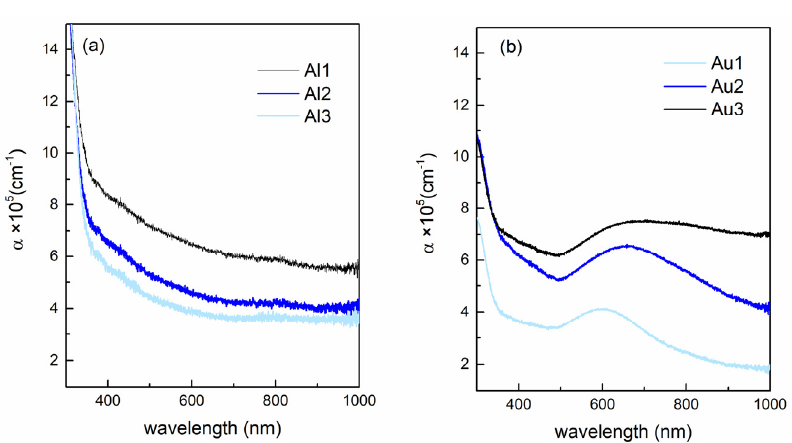
Figure 4. Optical properties of the films. Absorption coefficient vs. wavelength for ( a ) Al-based and ( b ) Au-based films.